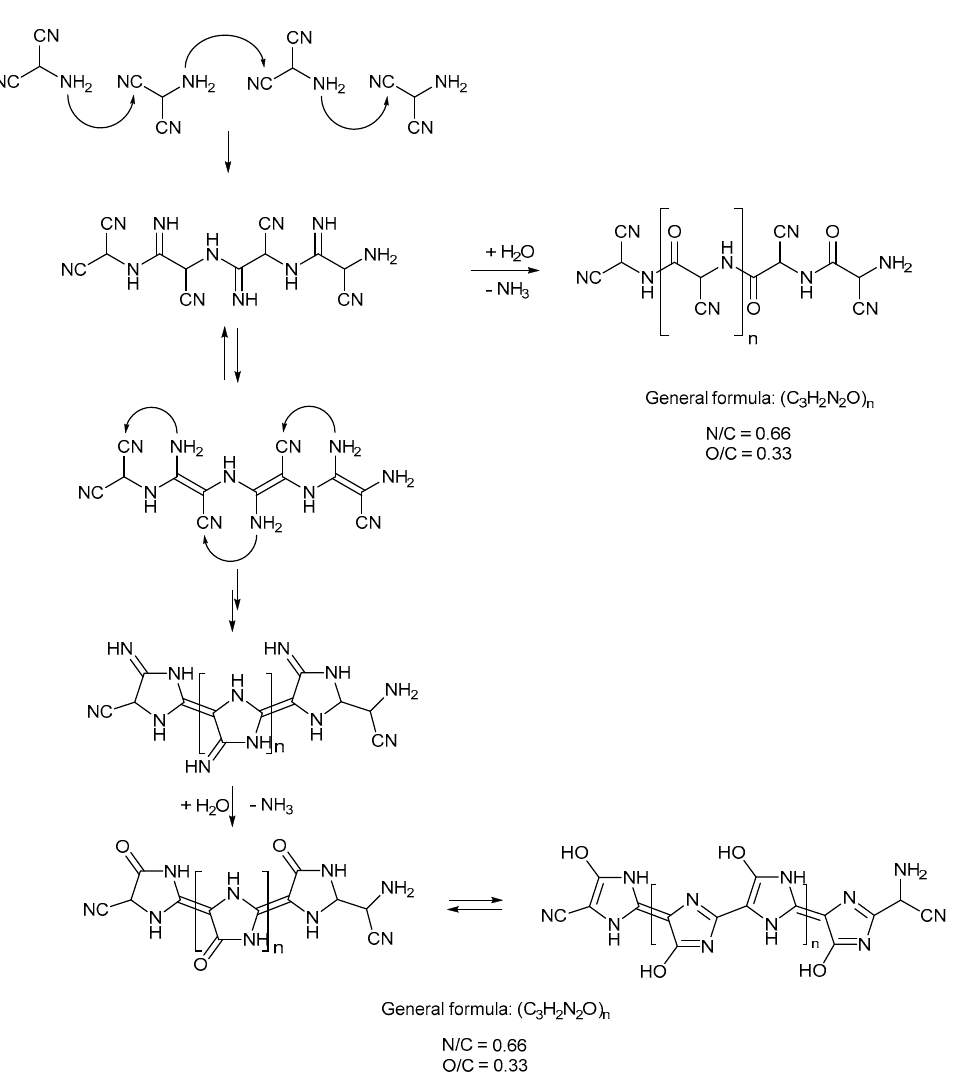
Figure 4. ( A ) X-ray photoelectron spectroscopy (XPS) survey spectra of AMN-based films after different deposition times (1 h and 19 h) on glass slides. ( B ) Evolution of the atomic percentage of Si (  ), O (  ), N (  ) and C (  ) as a function of time for AMN based coatings deposited from a 10 mg·mL − 1 solution. The coatings were deposited on Si containing glass slides. ( C ) Evolution of the O/C (  ) and N/C (  ) ratios with reaction time in a 10 mg·mL − 1 AMN solution. The error bars cor- respond to ± one standard deviation. Reproduced with permission from [12], Copyright American Chemical Society,